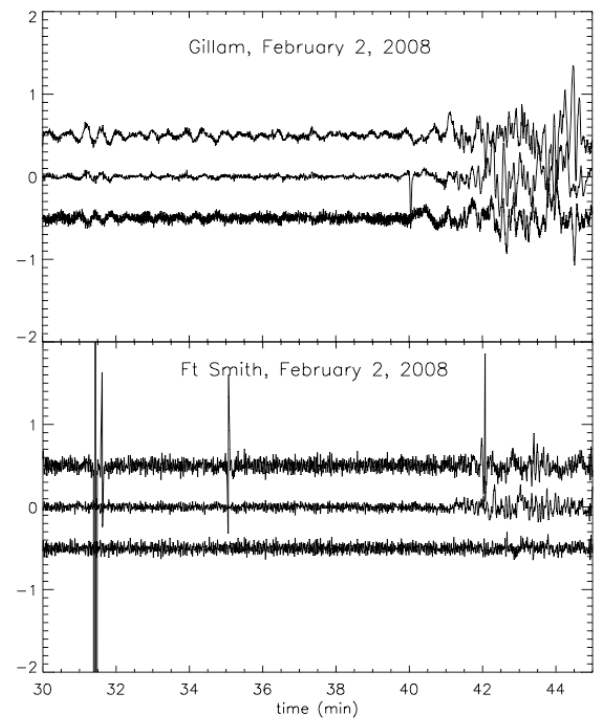
Fig. 9. Magnetic fluctuations B x , B y and B z at Gillam and Ft. Smith. Larger amplitude fluctuations begin at Gillam at Figure 9. Magnetic fluctuations Bx, By and Bz at Gillam and Ft. Smith. Larger amplitude fluctuations begin at Gillam at 7:40 UT.